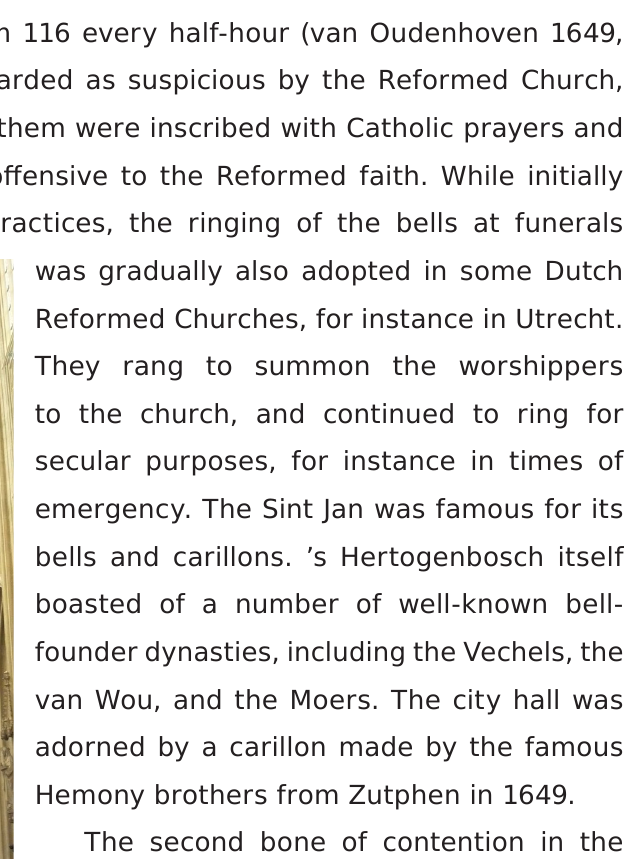
The Organ, Sint Jan, at ’s Hertogenbosch, organ pipes by Florens Hocque, completed